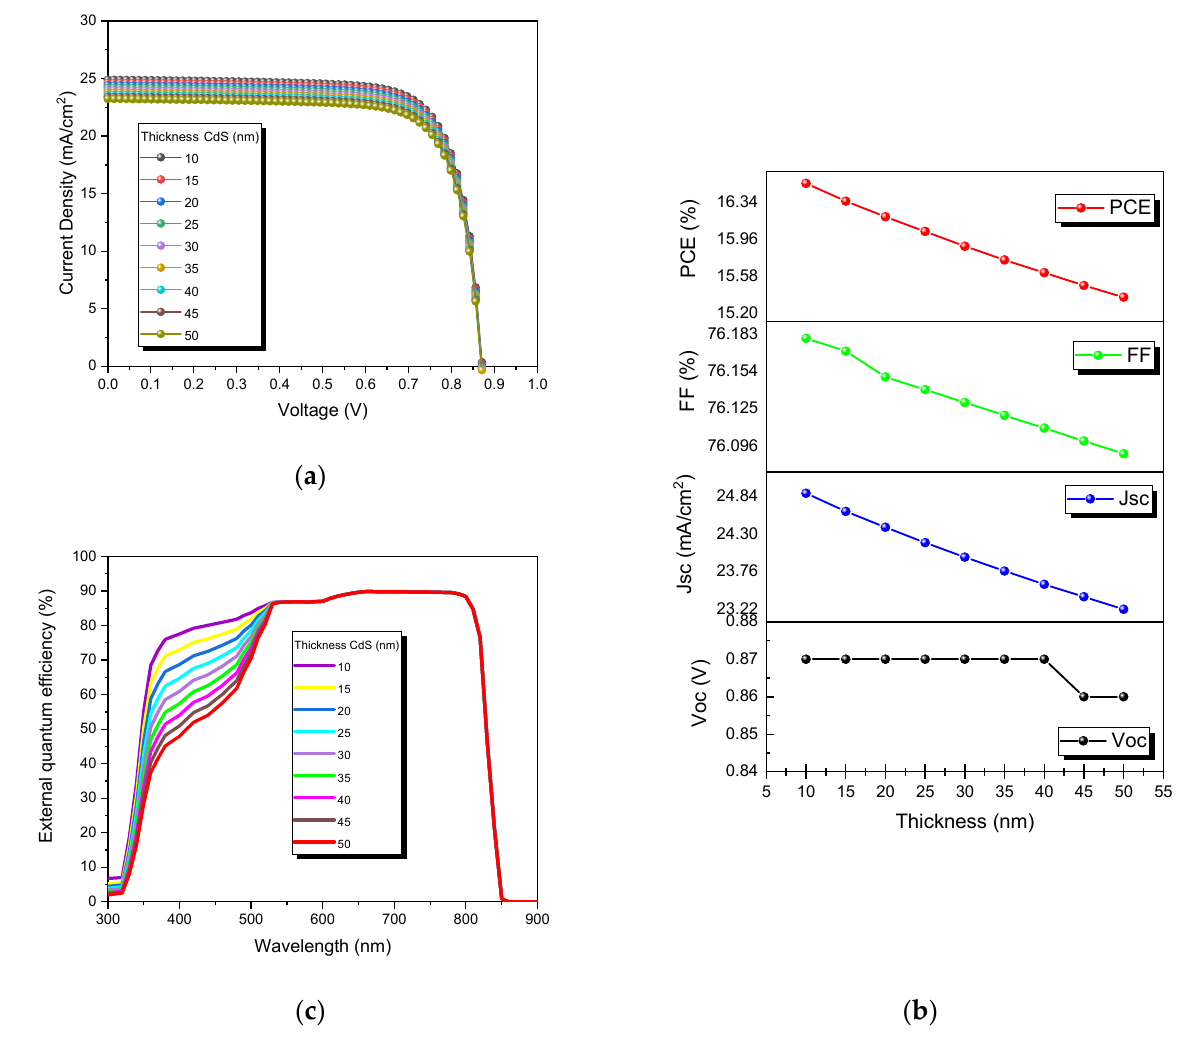
Figure 4. CdTe solar cells at different CdS thicknesses: ( a ) J-V curves, ( b ) output parameters, and ( c ) external quantum efficiencies.